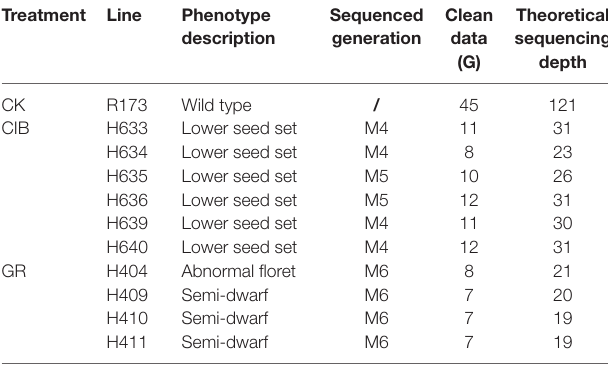
TaBLe 1 | The phenotypes and resequencing information of the mutant